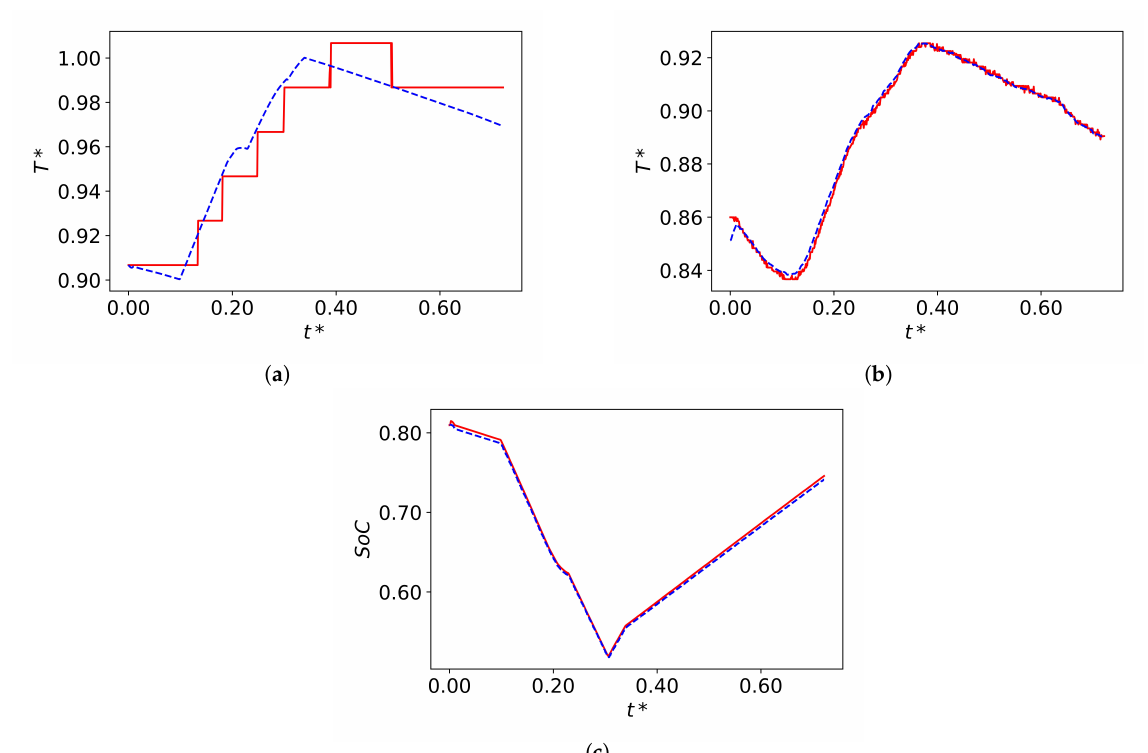
Figure 7. Results for Case 1: ( a ) average battery pack temperature, ( b ) outlet coolant temperature and ( c ) average battery pack SoC . Measured quantity ; simulated quantity